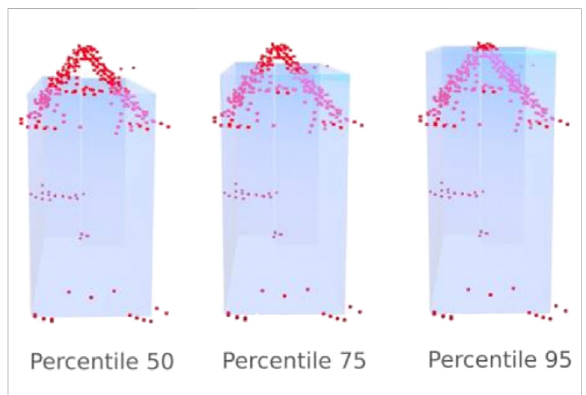
FIGURE 3 Calculated building height depending on percentiles and points belonging to that building, fi gure adapted from Dukai et al.